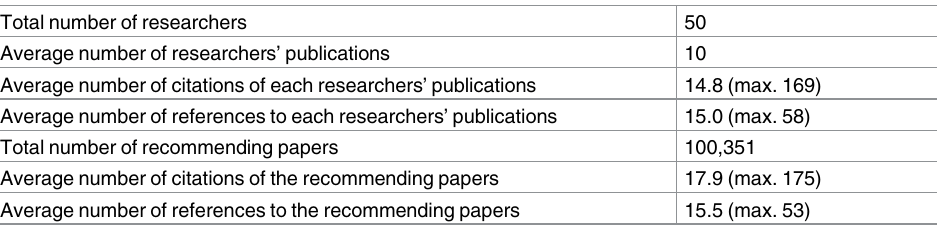
Table 1. Statistics of the utilized